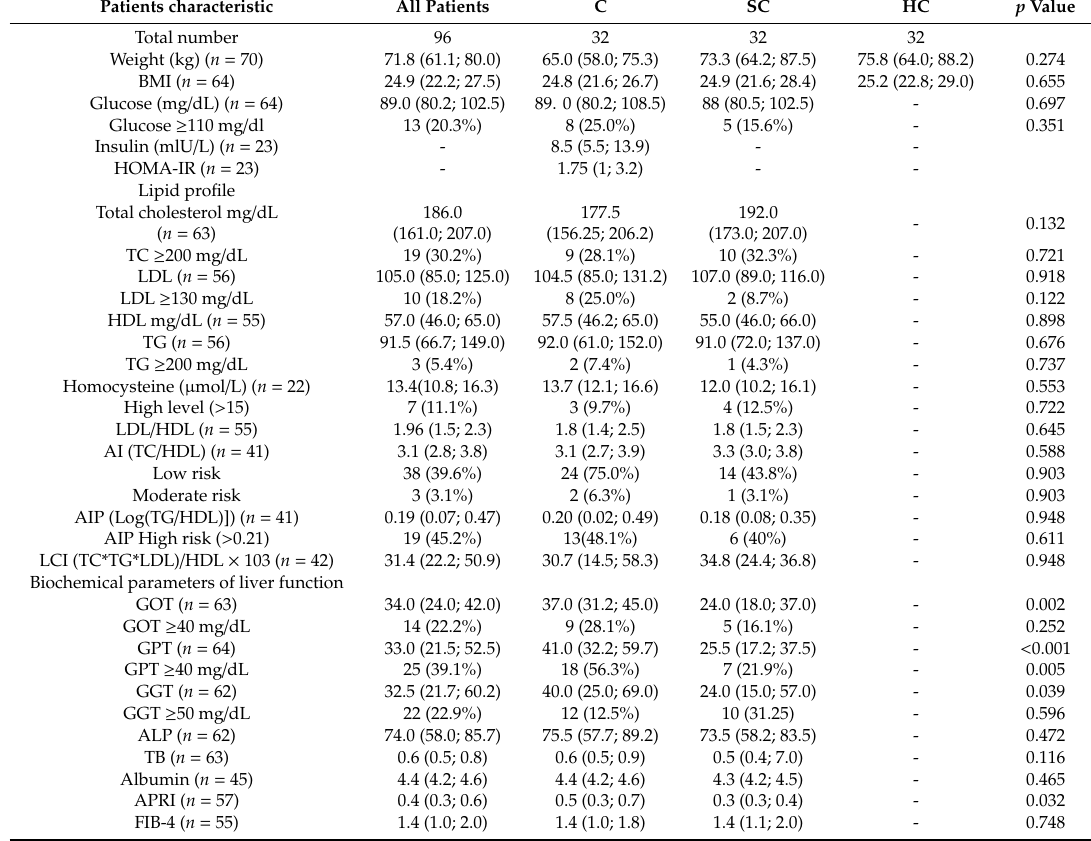
Table 2. Clinical characteristics of metabolic and liver